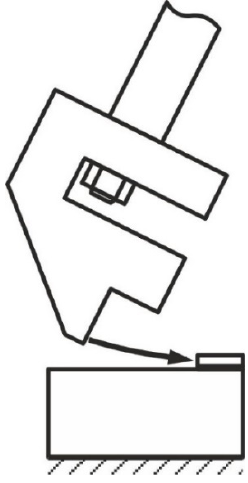
Figure 4. Diagram of impact strength testing in block specimens.